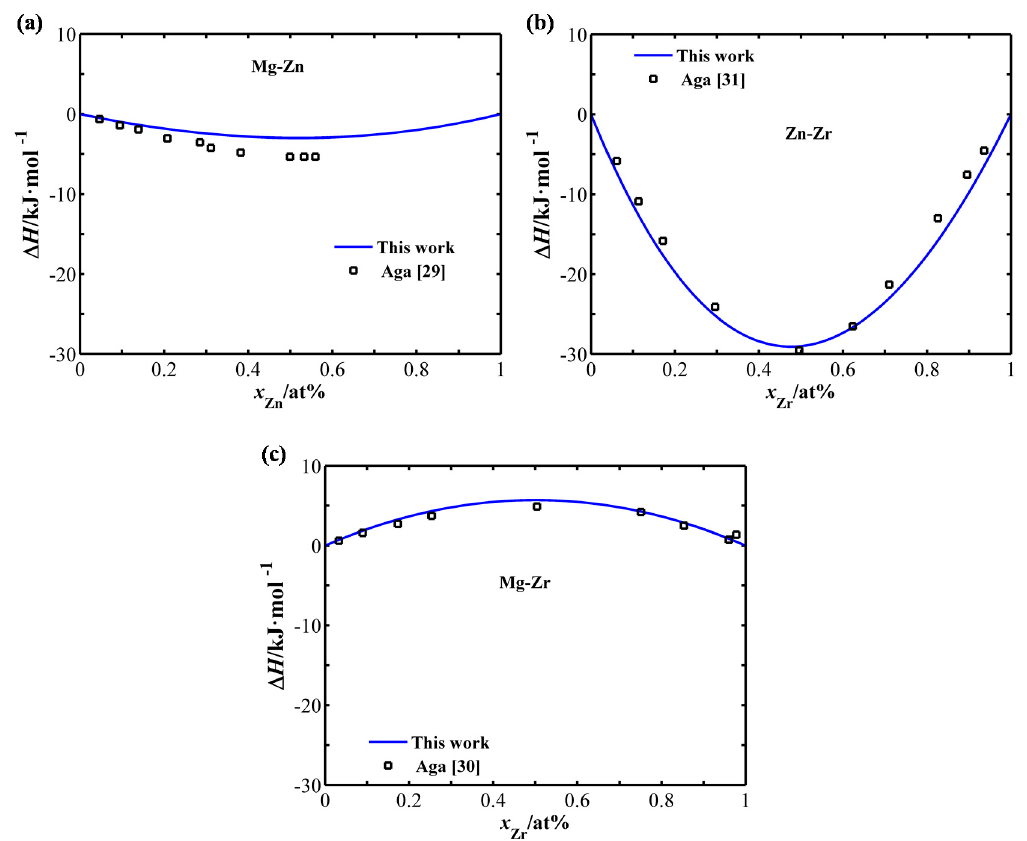
Figure 1. Calculated mixing enthalpy ∆ H of liquid Mg-Zn ( a ), Zn-Zr ( b ), and Mg-Zr ( c ) alloys with experimental data and calculated Calphad-data from the literature [29–31].